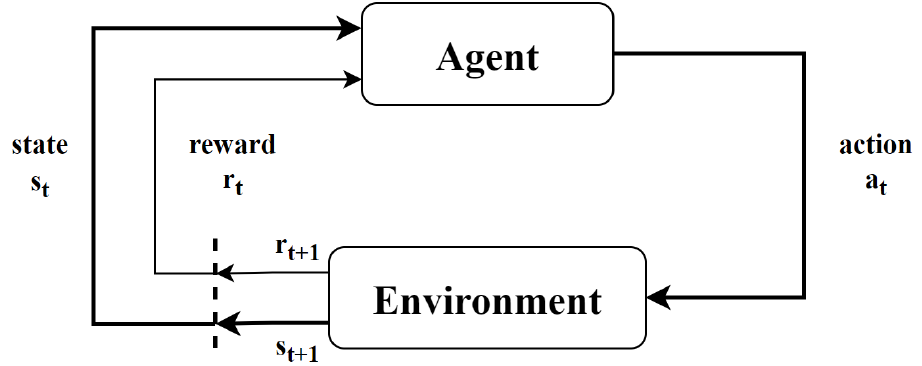
Figure 1. Agent–environment interaction in RL